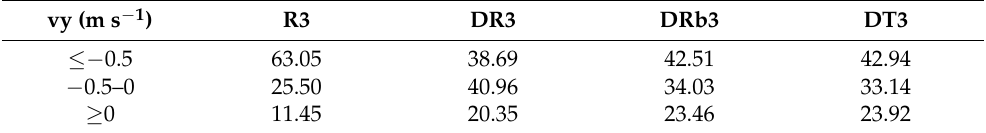
Figure 9. Uphill component of velocity vector in pool 3 and 4 for rectangular boulder layout ( a ), double rectangular boulder with a small barrier layout ( b ) and double Trapezoidal boulders ( c ). Table 4. Percentage of flow area occupied by each uphill velocity range and layout type: rectangular boulder layout (R3), double rectangular boulder (DR3), double rectangular boulder with a small barrier layout (DRb3) and double trapezoidal boulders (DT3). The percentage has been calculated respect of the pool area.